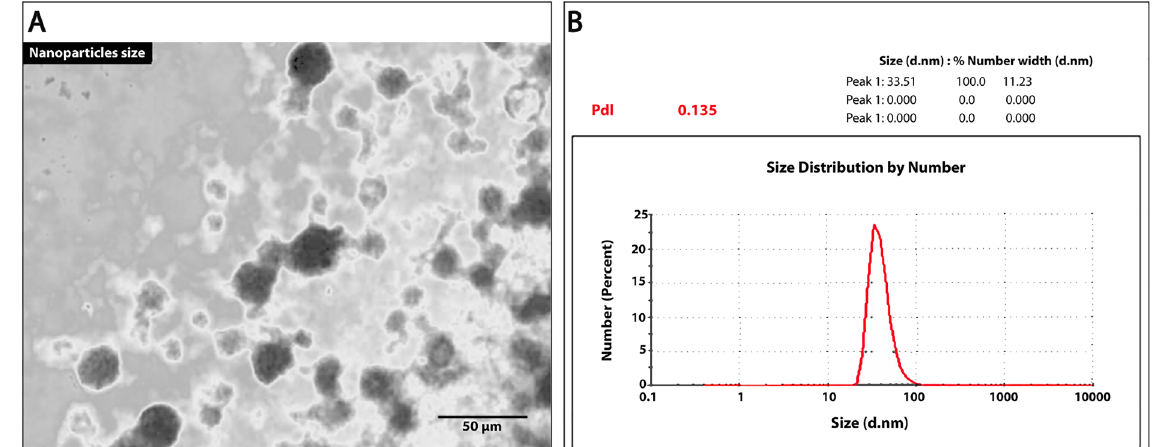
Figure 1. ( A ) Transmission electron microscopy images of self-nanoemulsifying dopamine delivery system nanoparticles synthesized on this study. Dopamine nanoform of 32.6: 48.5 nm, particles perceived to be spherical in shape. ( B ) Size distribution and zeta potential of DA-nanoparticles were determined using light scattering